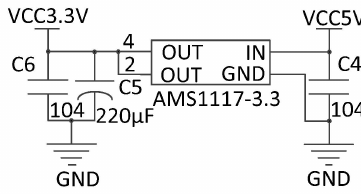
Figure 8. Power conversion module circuit.